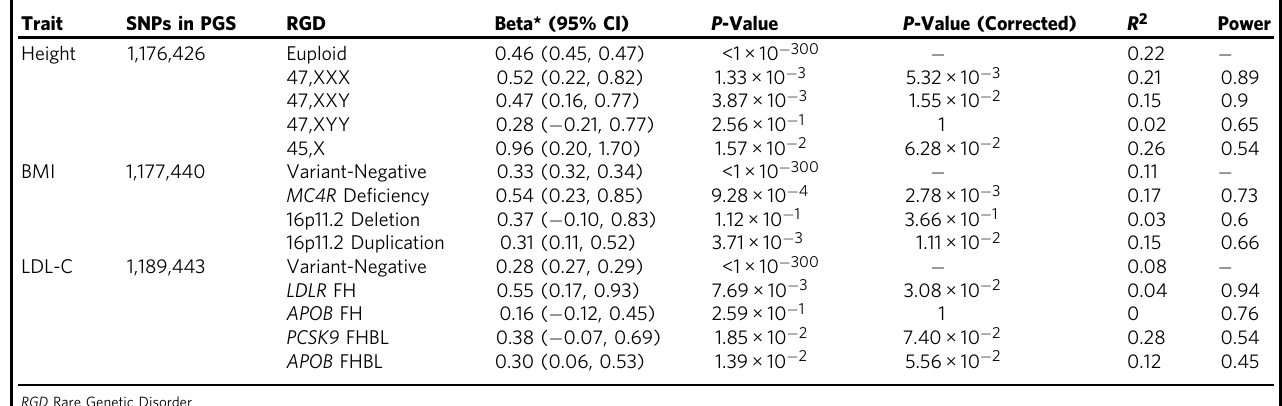
RGD Rare Genetic Disorder CI Con fi dence Interval PGS Polygenic Score FH Familial Hypercholesterolemia FHBL Familial Hypobetalipoproteinemia *Per 1SD increase of the PGS